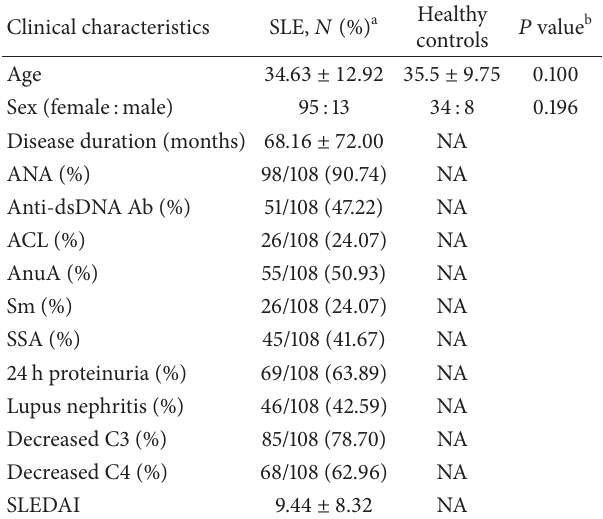
Table 1: Clinical and laboratory characteristics in patients with SLE and healthy